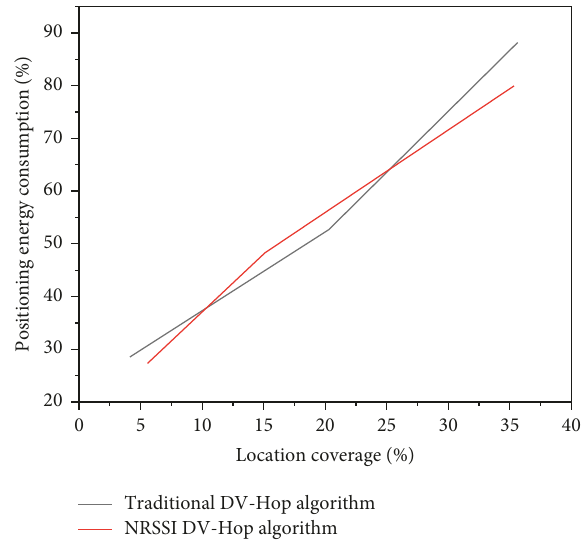
Figure 13: Comparison of positioning energy consumption.